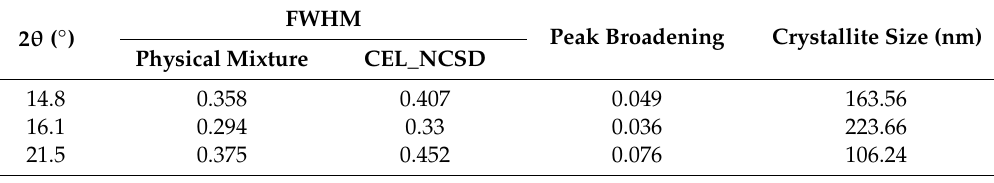
Table 1. Peak full width at half maxima (FWHM) values and peak broadening of PXRD peaks of CEL crystals in the physical mixture and CEL_NCSD.